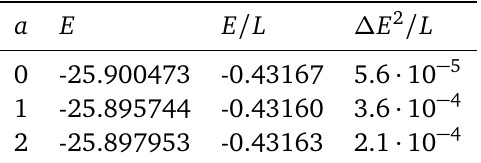
Table 1: Total energy and energy per spin of the three symmetry-broken ground / L = − 0.431 ( 7 ) can be estimated. The last column shows the states, from which E 0 energy variance per site, Eq. (3).